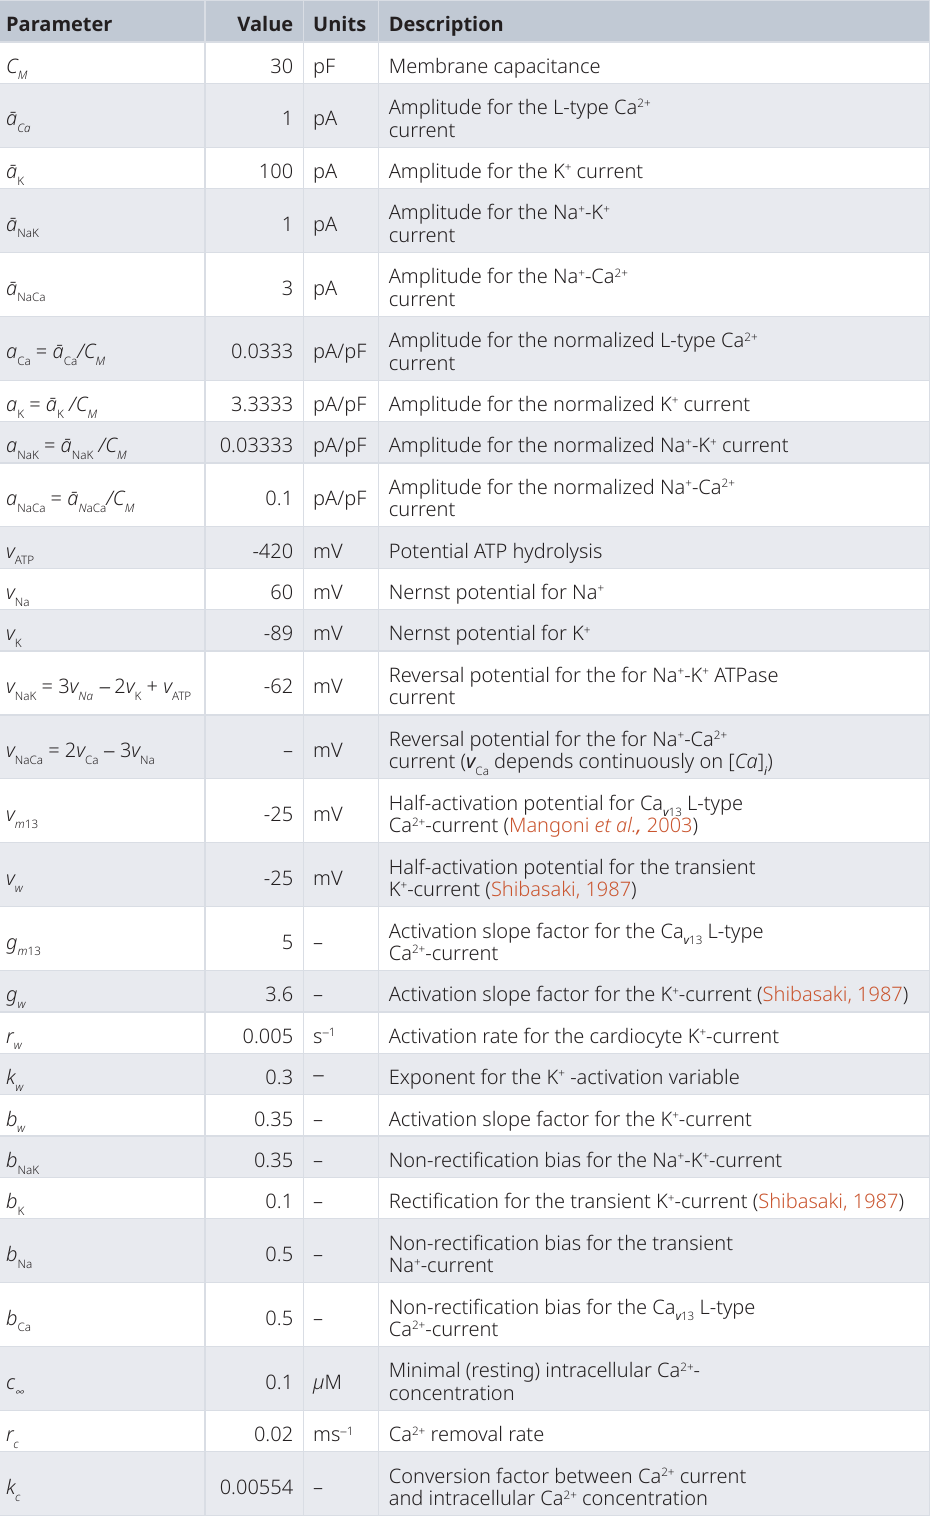
Table 3. Parameters for the cardiac SAN pacemaker model. The amplitudes a as ā /C where C is a constant that represents the rate of change in charge around the membrane as a l M M function of v , and l ∈ {Ca L , K, NaK,